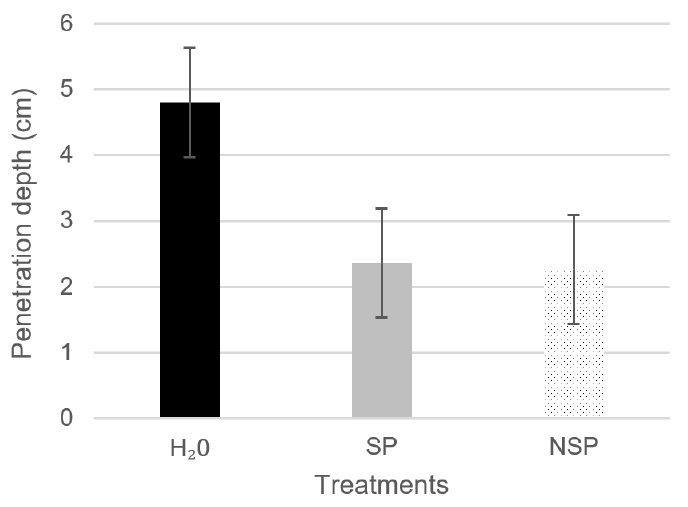
Figure 6. Average penetration depth of water under pressure in water-, SP- and NSP-treated recycled concrete specimens.